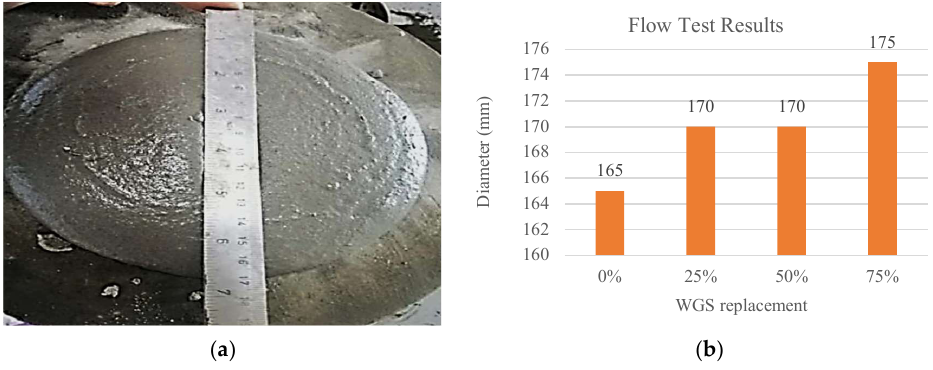
Figure 5. (a) Flow Test Measurement; ( b ) Flow Test Results. Figure 5. ( a ) Flow Test Measurement; ( b ) Flow Test Results.